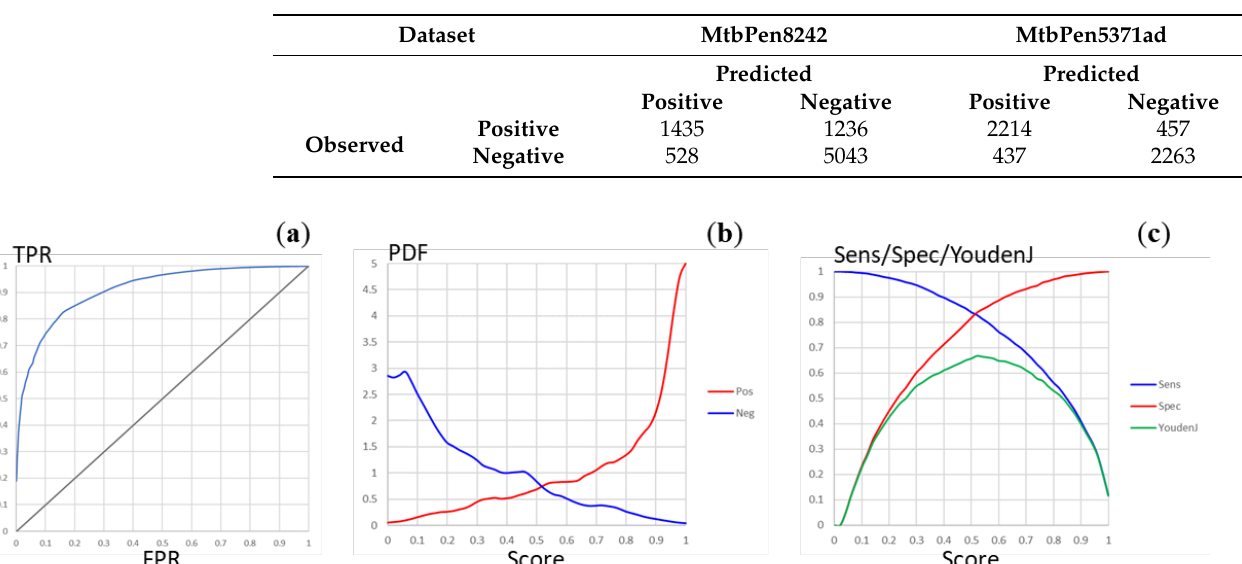
Figure 3. Plots of the model quality parameters for the MtbPen classification model. ( a ) The ROC curve (TPR, true positive rate; FPR, false positive rate). ( b ) The distribution densities (PDF, probability density function) of the penetration probability scores for the positive and negative com-